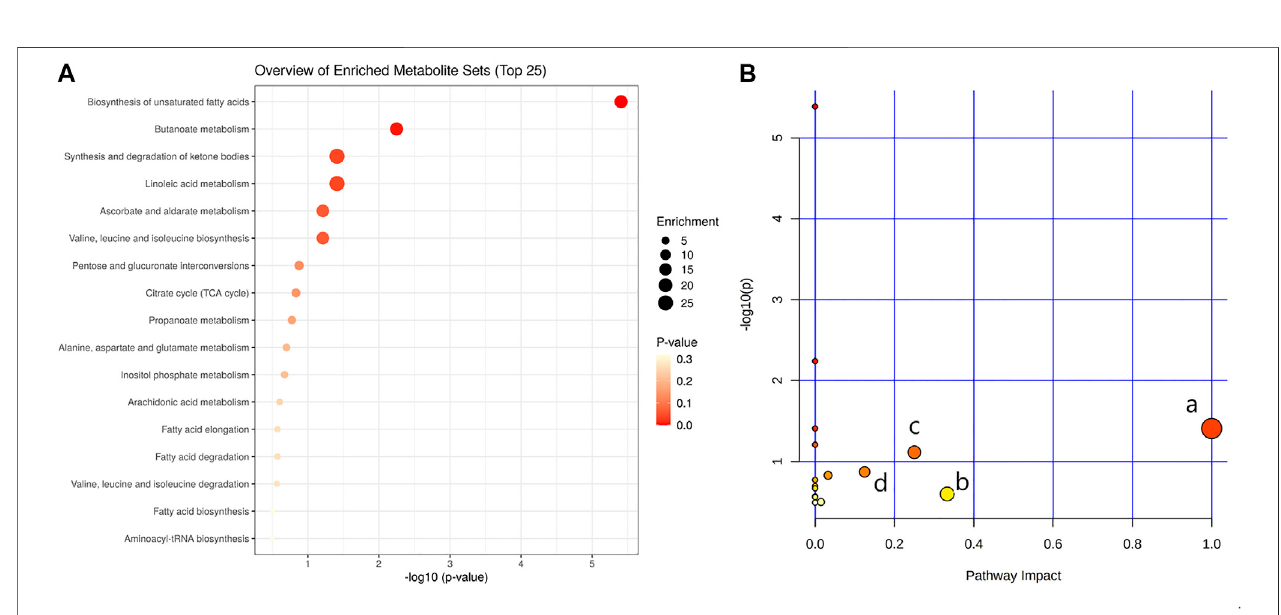
FIGURE 5 | Pathway enrichment analysis (A) and metabolic pathway analysis (B) . a, linoleic acid metabolism; b, arachidonic acid metabolism; c, ascorbate and aldarate metabolisml; d, Pentose and glucuronate interconversions.